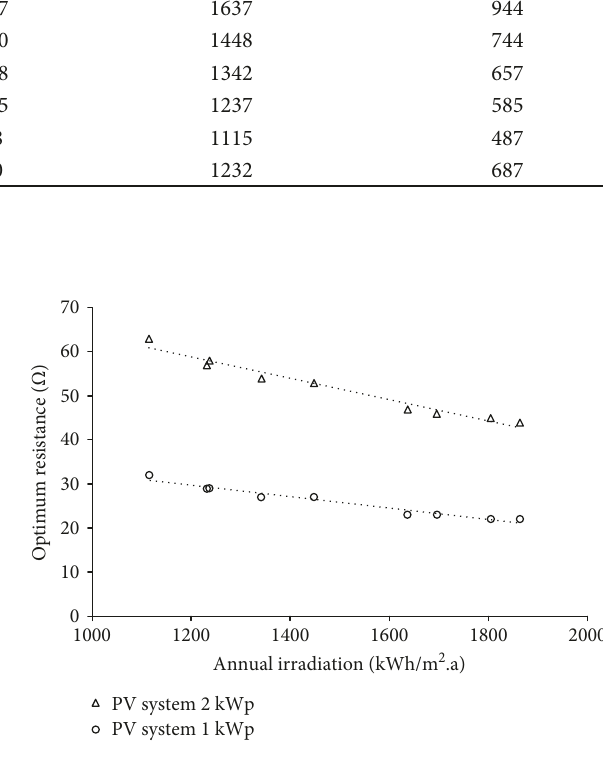
Figure 3: Optimum load resistance of PV arrays as a function of annual solar